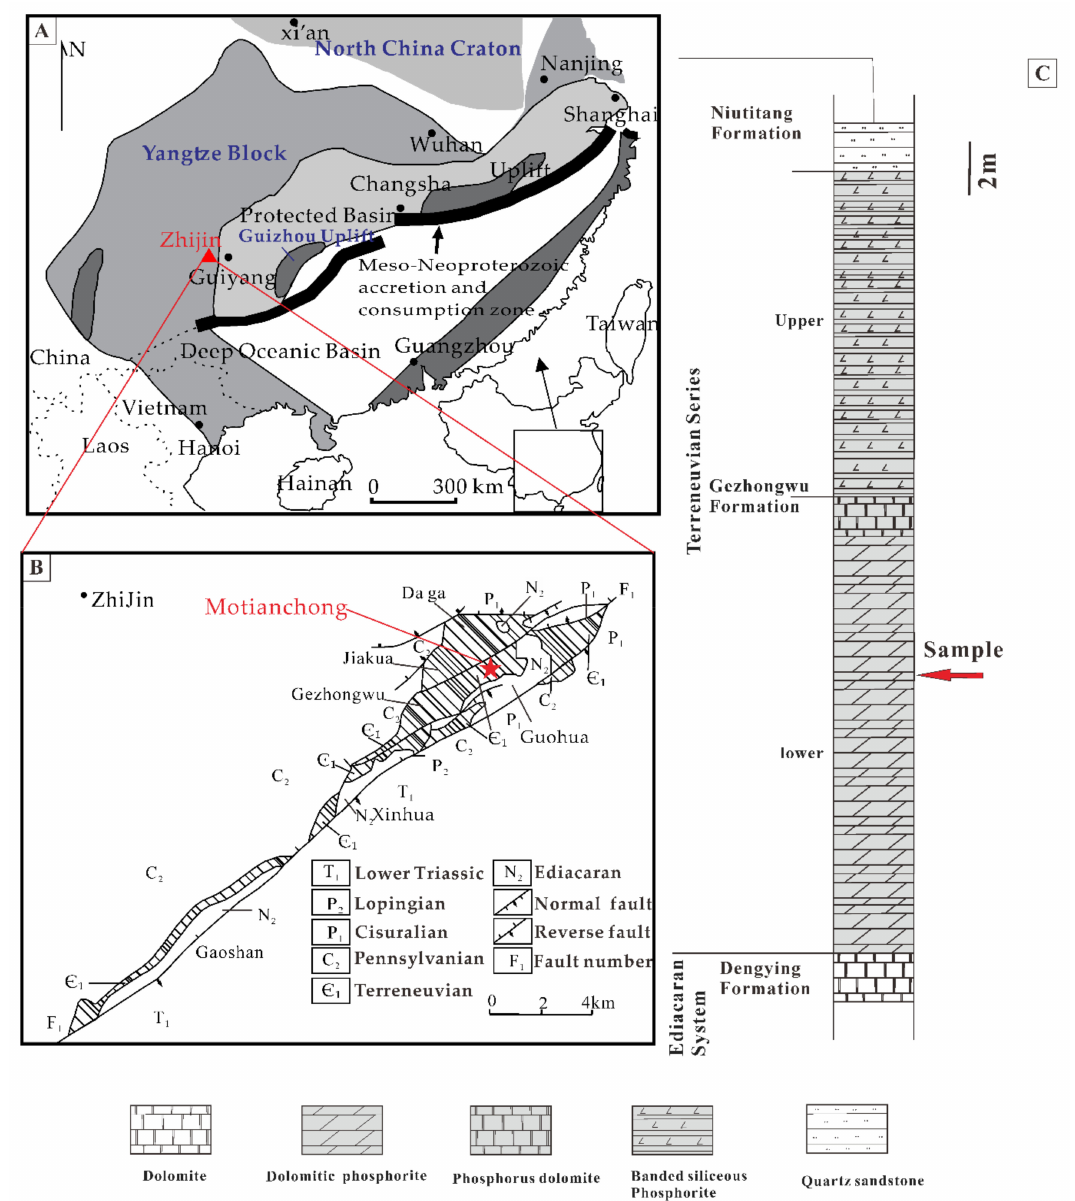
Figure 2. ( A ) Tectonic Map of the Yangtze Block (From Fan et al. 2016 [30]); ( B ) Tectonic Map of the Zhijin, Guizhou (From Wu, 1999 [3]); ( C ) Simplified stratigraphic column of the Gezhongwu Formation at Motianchong ore